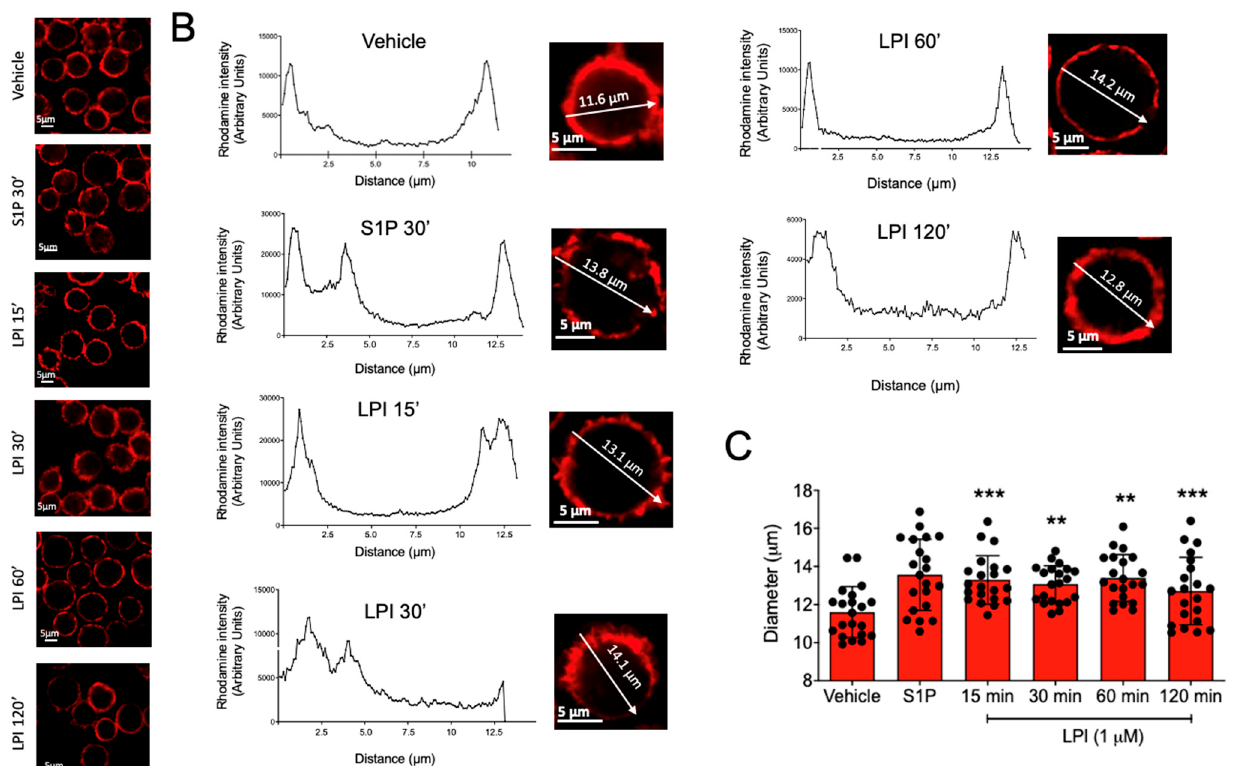
Figure 2. LPI-induced changes in cell size and actin ring polymerization in MCs. Panel ( A ): representative images of BMMCs stained with rhodamine-labeled phalloidin after treatments with vehicle, S1P (1 µ M), and LPI (1 µ M) at distinct times. Panel ( B ): representative images and analysis of cell size and the polymerization of the actin ring of BMMCs treated with S1P and LPI at distinct times. Utilizing the confocal microscopy software Zen 2.3 SP1 Blue Edition, a line was traced crossing at the equatorial plane of the individual cells and fluorescence values along the line were collected to calculate cell size using the graphs shown. Panel ( C ): quantification of changes in cell size induced by LPI in BMMC. Data are presented as the mean ± SEM of at least 20 cells analyzed under each condition; ** p < 0.01; *** p < 0.001 vs.